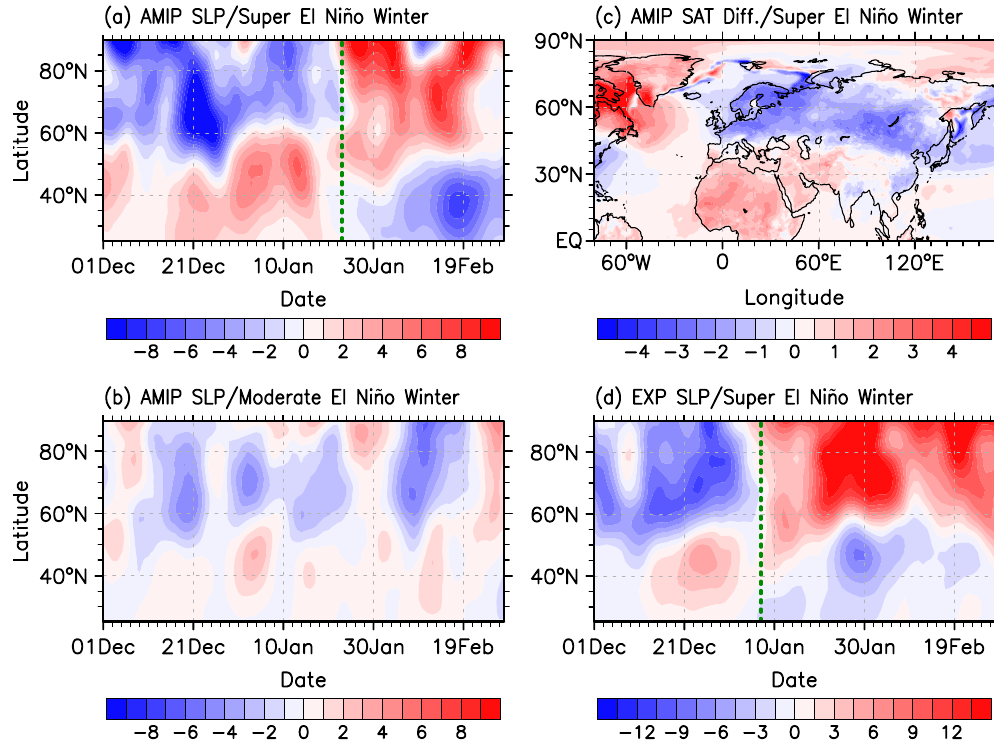
Figure 4. Model simulated responses to El Niño warming on the sub-seasonal timescale. Composite zonal averaged SLP anomalies (hPa) over the North Atlantic (80°W–30°E) region for ( a ) super and ( b ) moderate El Niño winters in GFDL-HIRAM AMIP-style simulations. ( c ) Composite SAT anomalies difference (°C) after and before the sub-seasonal NAO phase transitional date for super El Niño winters in GFDL-HIRAM AMIP- style simulations. ( d ) Zonal average ensemble-mean SLP anomalies (shading in hPa) over the North Atlantic (80°W–30°E) region for the super El Niño winter in the GFDL AM2.1 “Super El Niño” experiment. The green dashed lines in ( a ) and ( d ) approximately represent the NAO phase transition timing according to the NAO index. The figure was generated with the NCAR Command Language (Version 6.3.0) [Software]